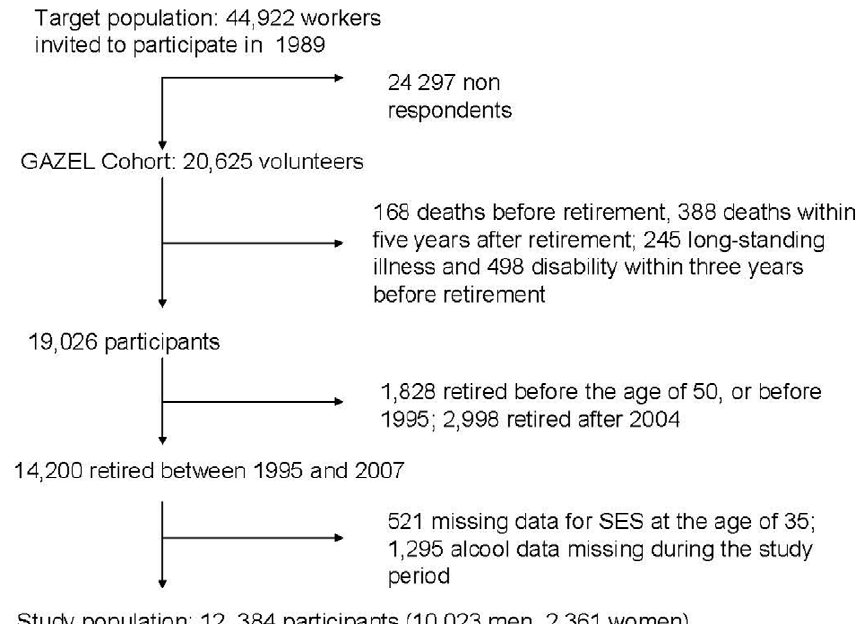
Figure 1. Flowchart describing the selection of participants in the study.